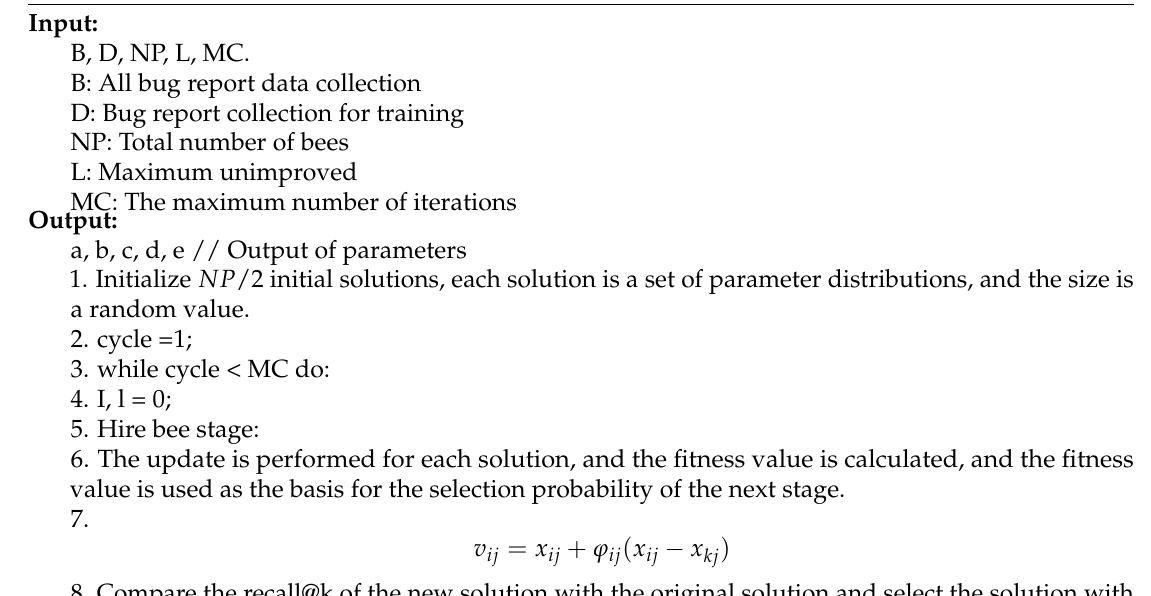
Algorithm 1 ABC-DR algorithm to train